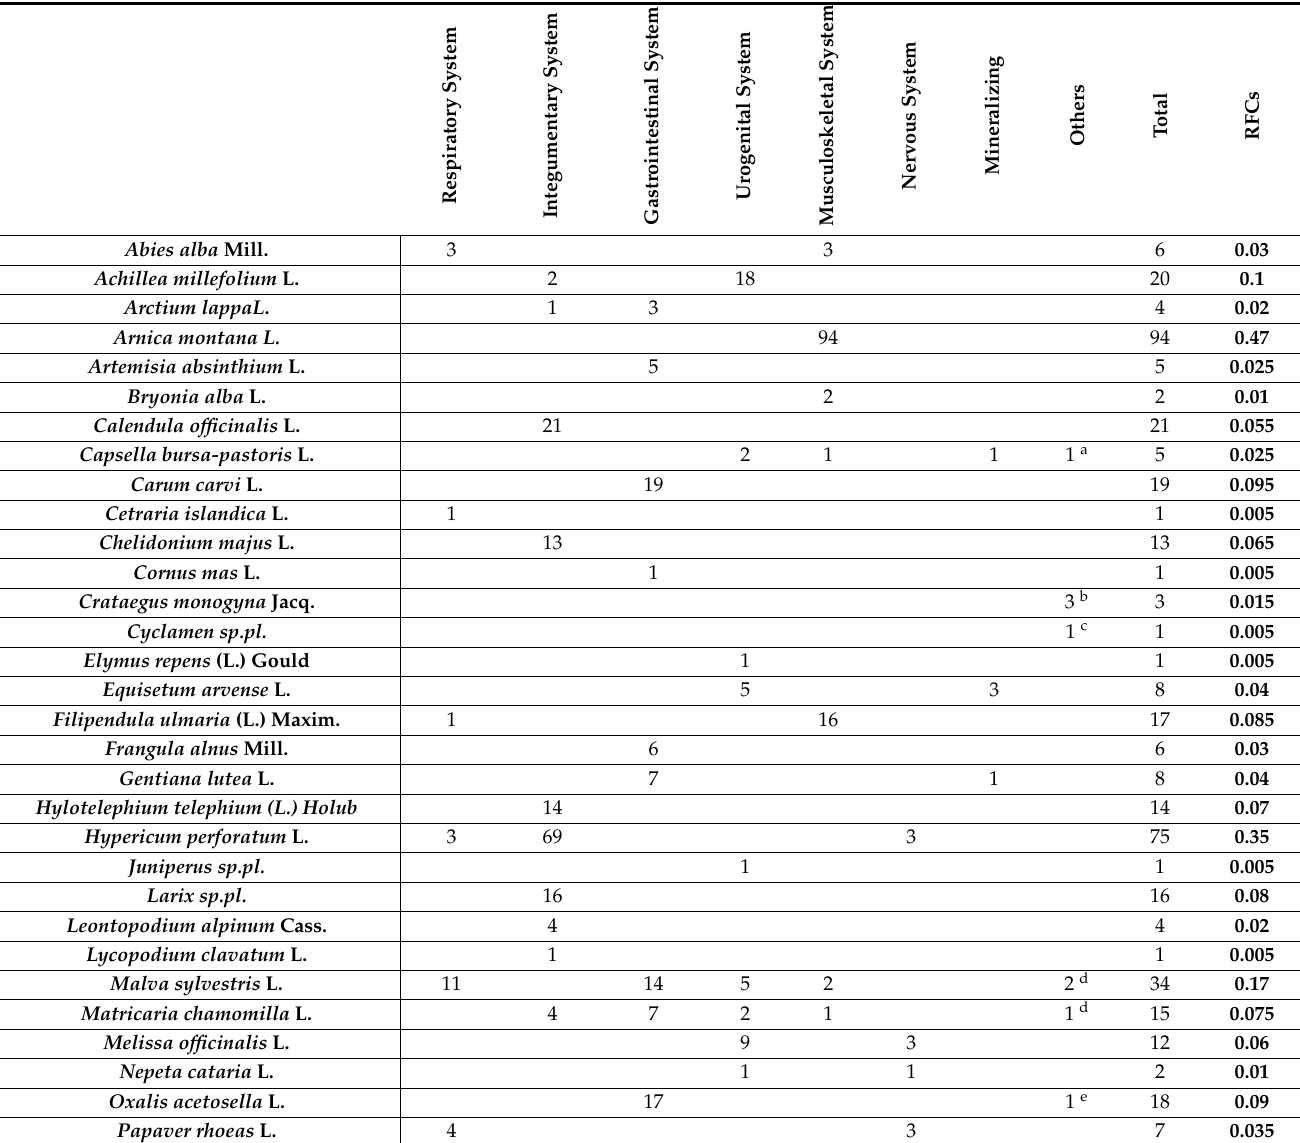
Table 4. Number of citations for plants cited in the medicinal field divided into the category of use and related frequency relative citation